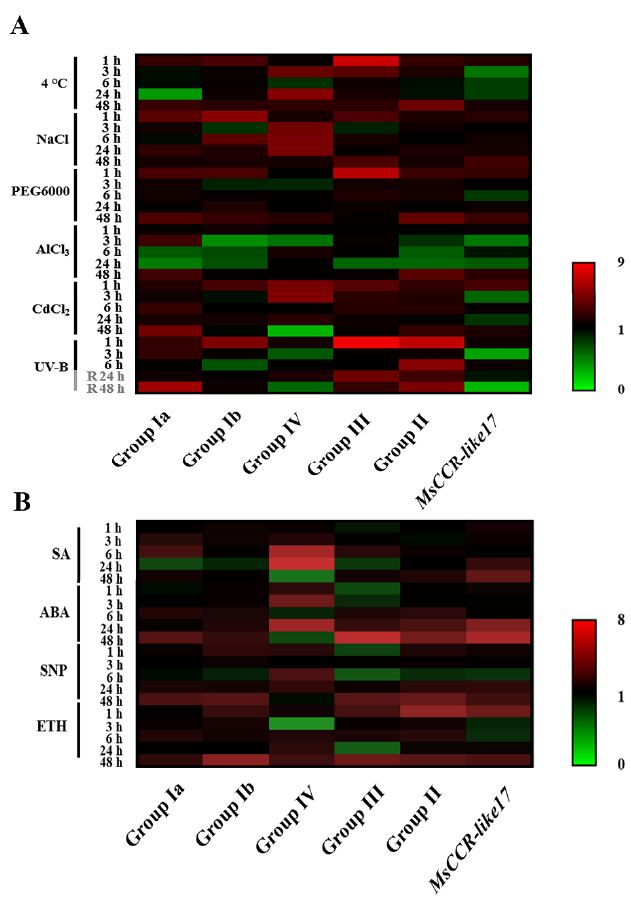
Figure 6. The expression profiles of MsCCR / MsCCR-like genes under different treatments and different times in M. sativa . Seven-day-old alfalfa seedlings were used for abiotic stresses ( A ) and phytohormone ( B ) treatment. After 1, 3, 6, 24, and 48 h of 4 °C, NaCl (100 mM), PEG6000 (15%), AlCl 3 (150 µ M), CdCl 2 (100 µ M), SA (50 mg/L), ABA (50 mg/L), SNP (80 µ M), and ETH (500 µ M) treatment, the transcripts were analyzed by RT-qPCR. UV-B (1 J · m − 2 · h − 1 ) was treated for 6 h, followed by 12 h of recovery (in grey). Data were from three independent experiments with at least three replicates for each. Actin2 was used as internal reference, and the relative expression of each gene was further compared to control samples at the same time point under each treatment.